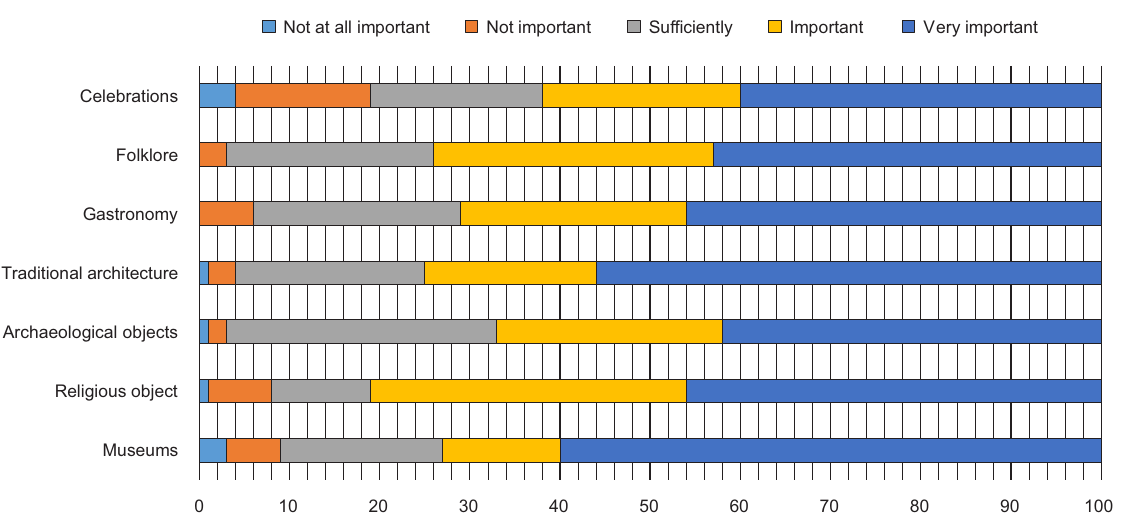
Fig. 7. Respondent’s assessment of the importance of cultural